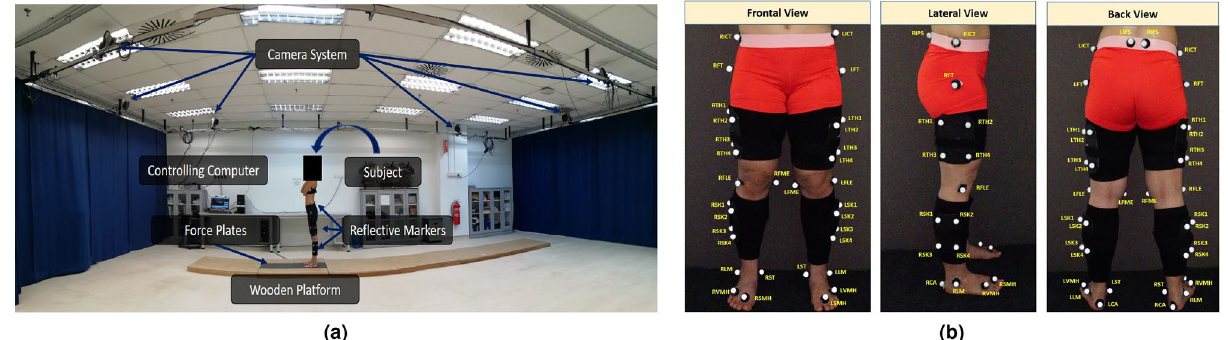
Figure 4. Data Collection Process ( a ) Laboratory setup with six motion cameras (ProReflex MCU, Qualisys, Gothenburg, Sweden) for joint motion measurements, two force plates (Bertec, type FP 4060-07, Bertec Corporation, OH, USA) embedded on to a 10m long wooden platform for vGRF measurements. ( b ) Marker placement with 36 markers recommended by Visual3D (C-motion Inc., Kingston, Canada). Double-sided adhesive stickers were used to stick markers on the segments and joints. Cluster markers with four individual markers were attached to each shank and thigh segments. Cluster markers were tighten using a stretchable band, to ensure no errors due to loosening attachments. All markers are labelled with a unique marker